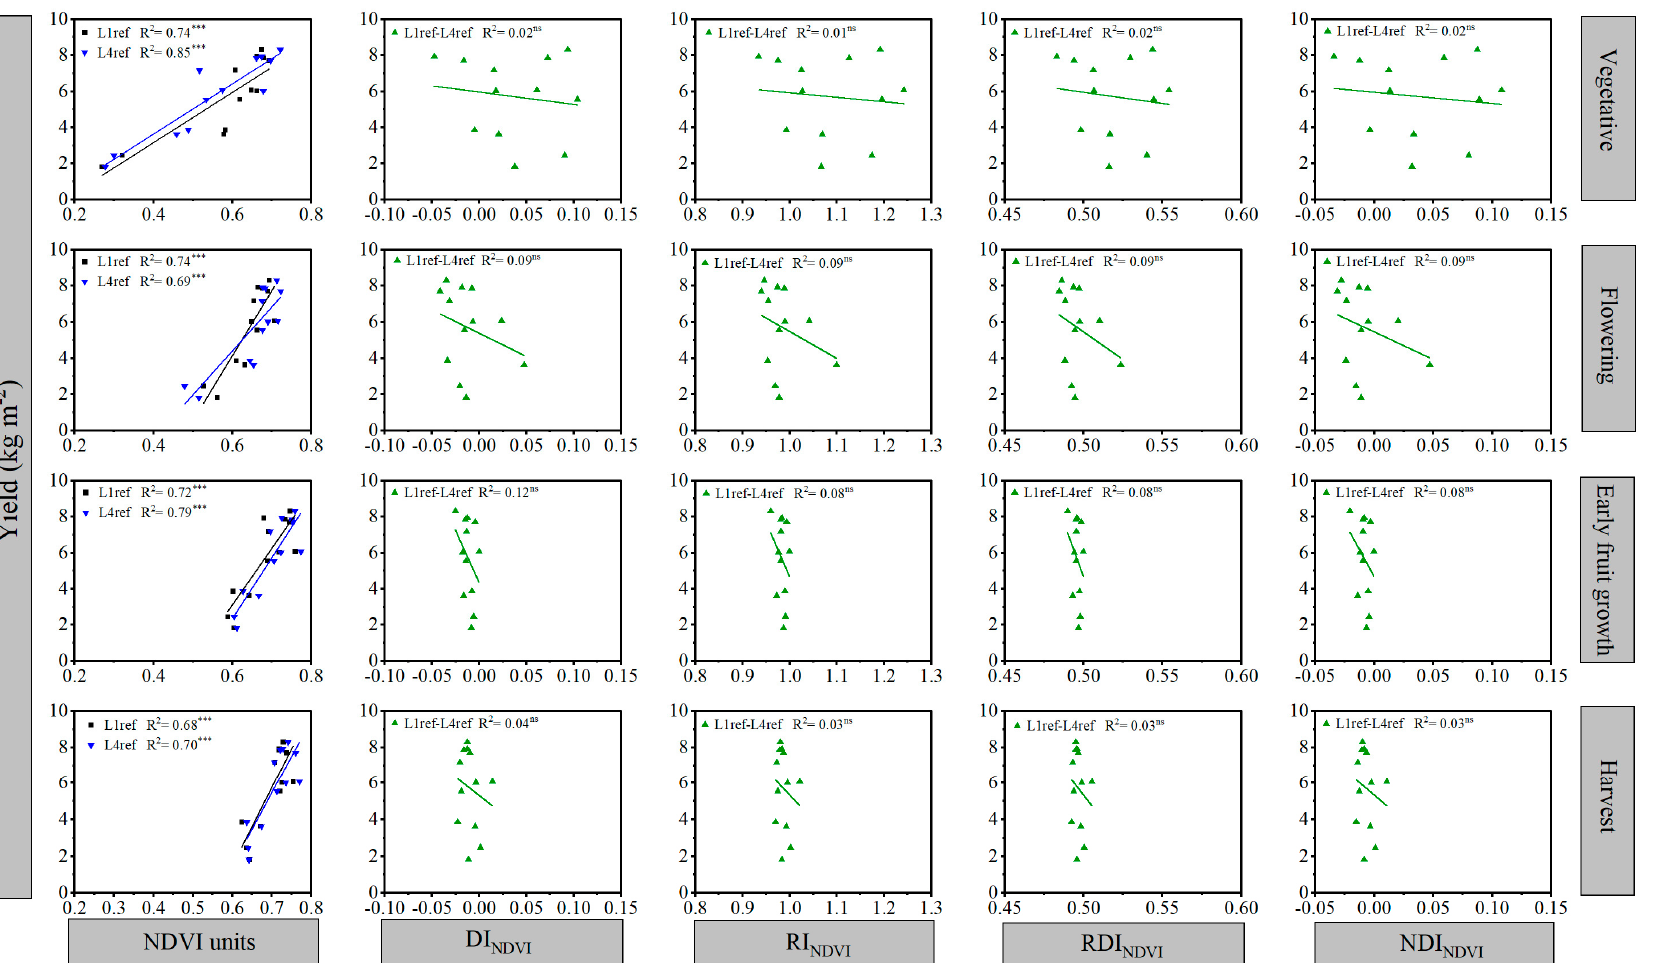
Figure 7. The relationships between absolute NDVI measurements and several normalized NDVI indices (DI, RI, RDI, NDI) with total fruit yield (kg m − 2 ) at different phenological stages of muskmelon, for calibration data. L1, L2, L3 and L4, refer to the latest (most recent) second, third and fourth fully expanded leaf, respectively. Asterisks show significance of regressions: ***, p < 0.001; ns, p > 0.05.